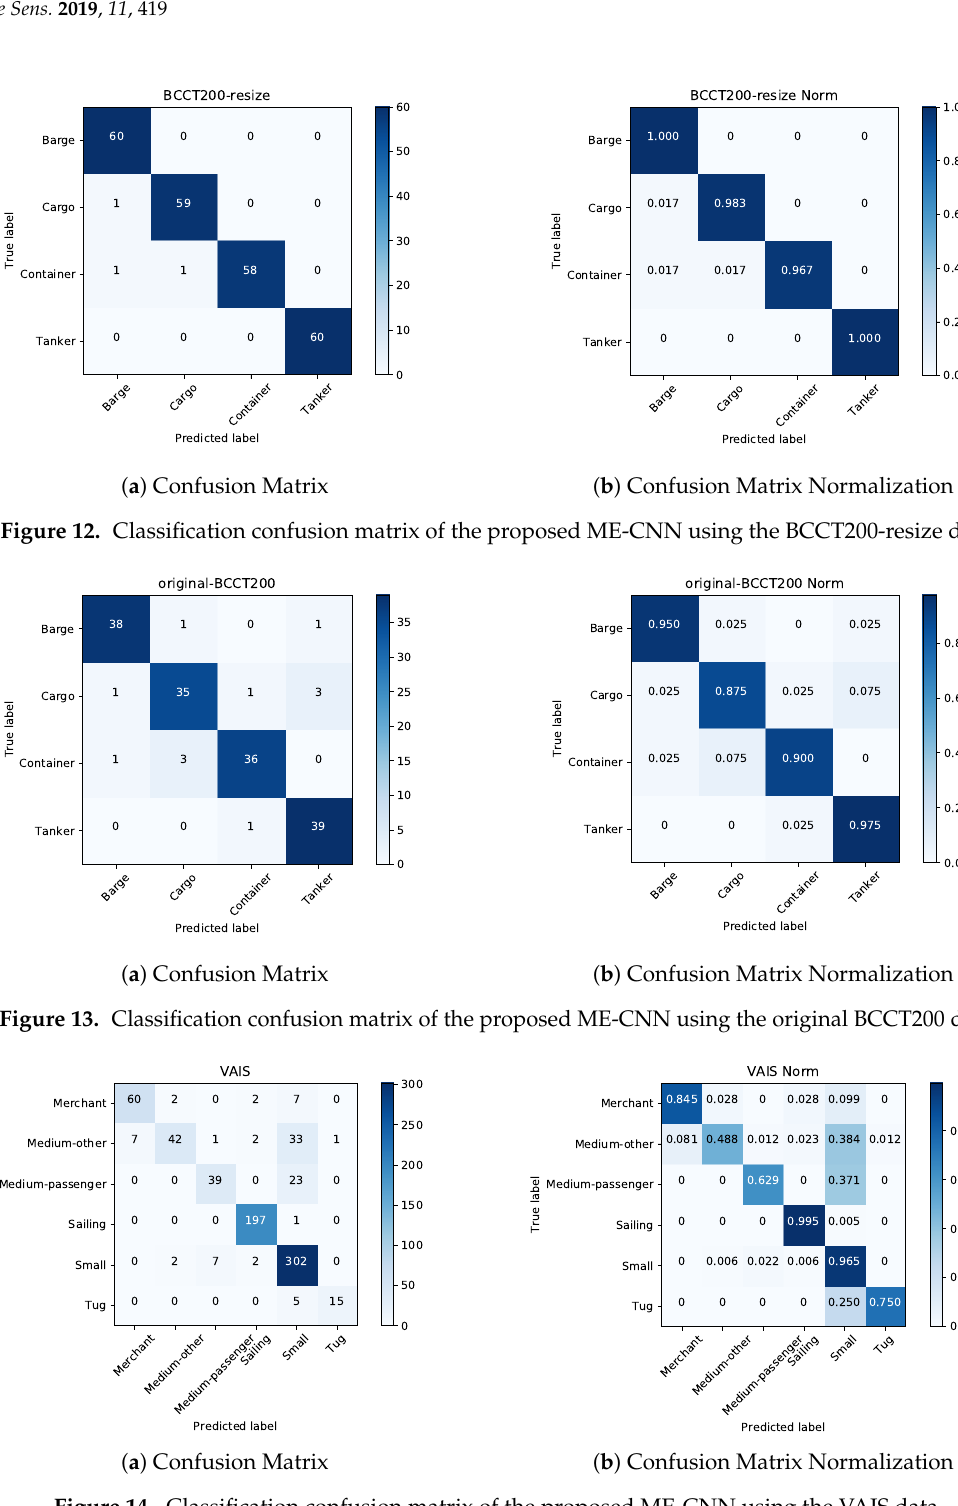
Figure 14. Classification confusion matrix of the proposed ME-CNN using the VAIS